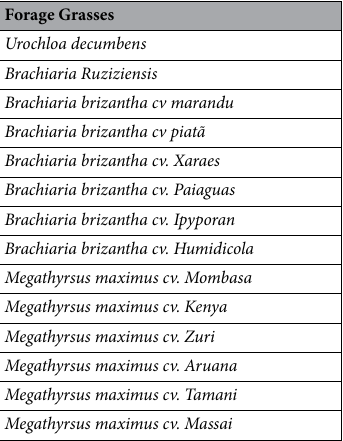
Table 1. Forage grasses installed at the Agrostological Field of the Ricardo Fontoura Experimental Station of the Cerrado, Evangelical College of